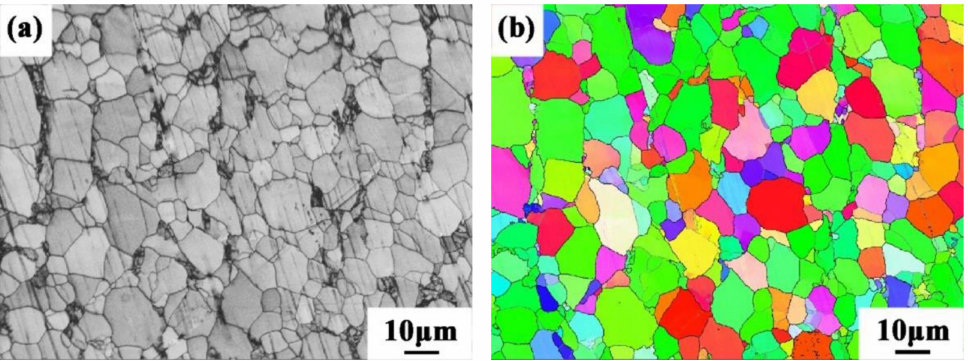
Figure 2. ( a ) Surface morphology and ( b ) electron backscatter diffraction (EBSD) image of the high-strength steel substrate.